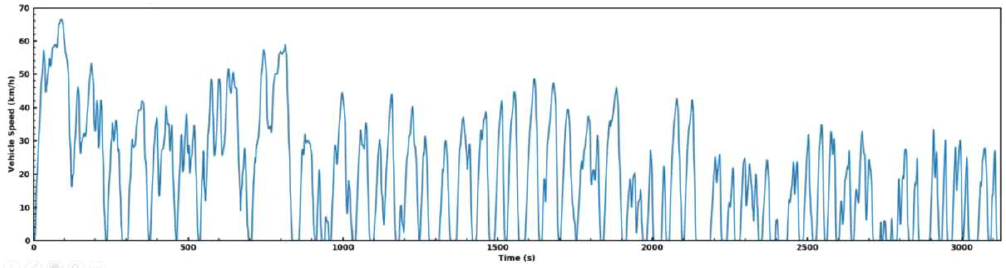
Figure 1. Millbrook London Transport Bus ( MLTB) test cycle speed-time profile.